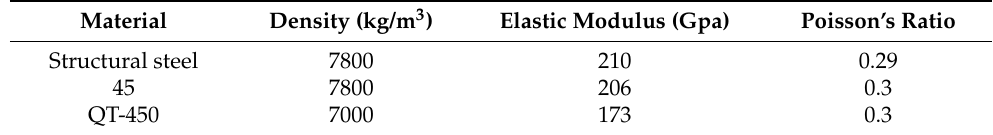
Table 4. Mechanical material parameter properties of each material.